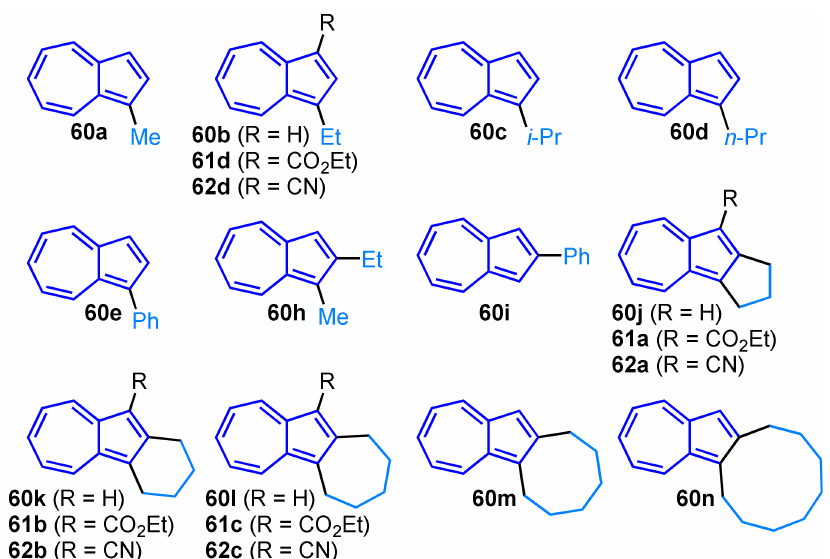
Figure 2. Structure of azulenes obtained by the [8 + 2] cycloaddition of 2 H -cyclohepta[ b ]furan-2-ones with enamines.